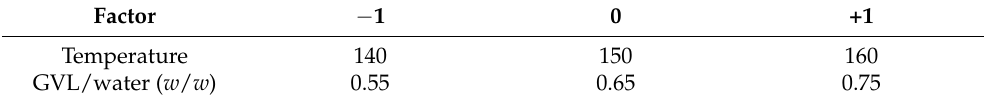
Table 1. Full factorial design factors and levels used for the cardoon stem fractionation process. Factor − 1 0 +1